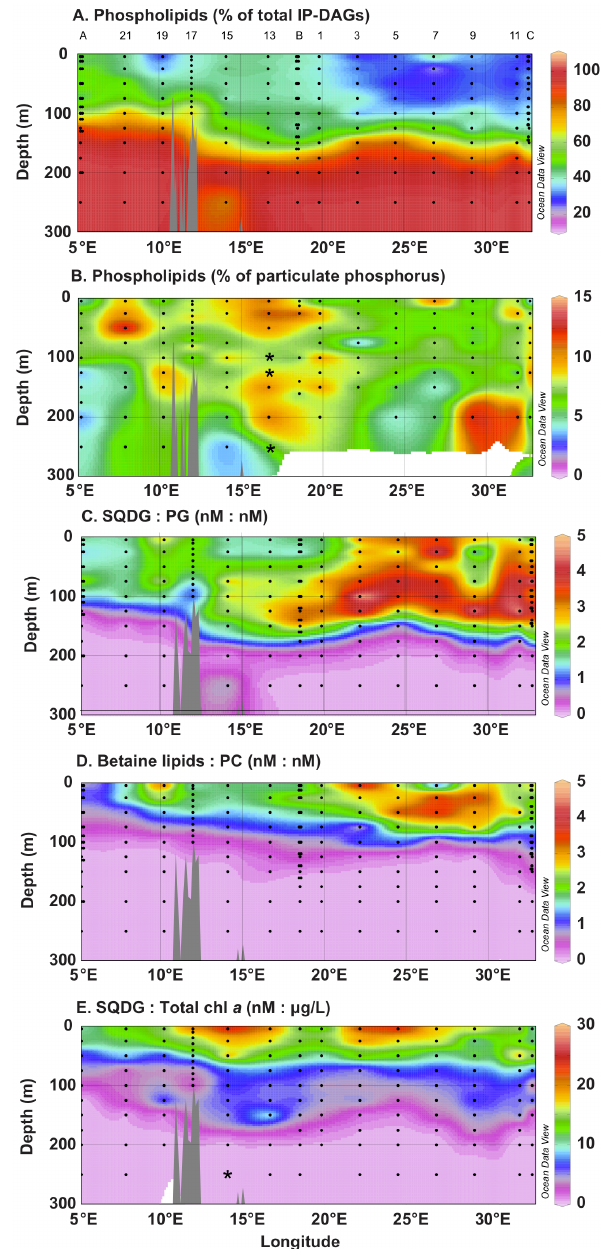
Fig. 4. Distribution of the ratios of lipids each shown in the upper 300m from west to east across the Mediterranean Sea. Total phos- pholipids (the sum of the concentrations of PG, PE and PC) are shown as a percent of total IP-DAGs (A) , and as a percent of total particulate phosphorus (B) . The ratios of the concentration of non- phosphorus lipids to phospholipids are shown as the ratio of the sul- folipid SQDG to the phospholipid PG (C) , and the ratio of the sum of the betaine lipids (DGTA, DGTS and DGCC) to the phospho- lipid PC (D) . Also shown is the ratio of SQDG to total chlorophyll- a (E) . Numbers across the top panel indicate station labels; black dots indicate individual samples, colored contours indicate interpolated gradients; * indicates outlier values not